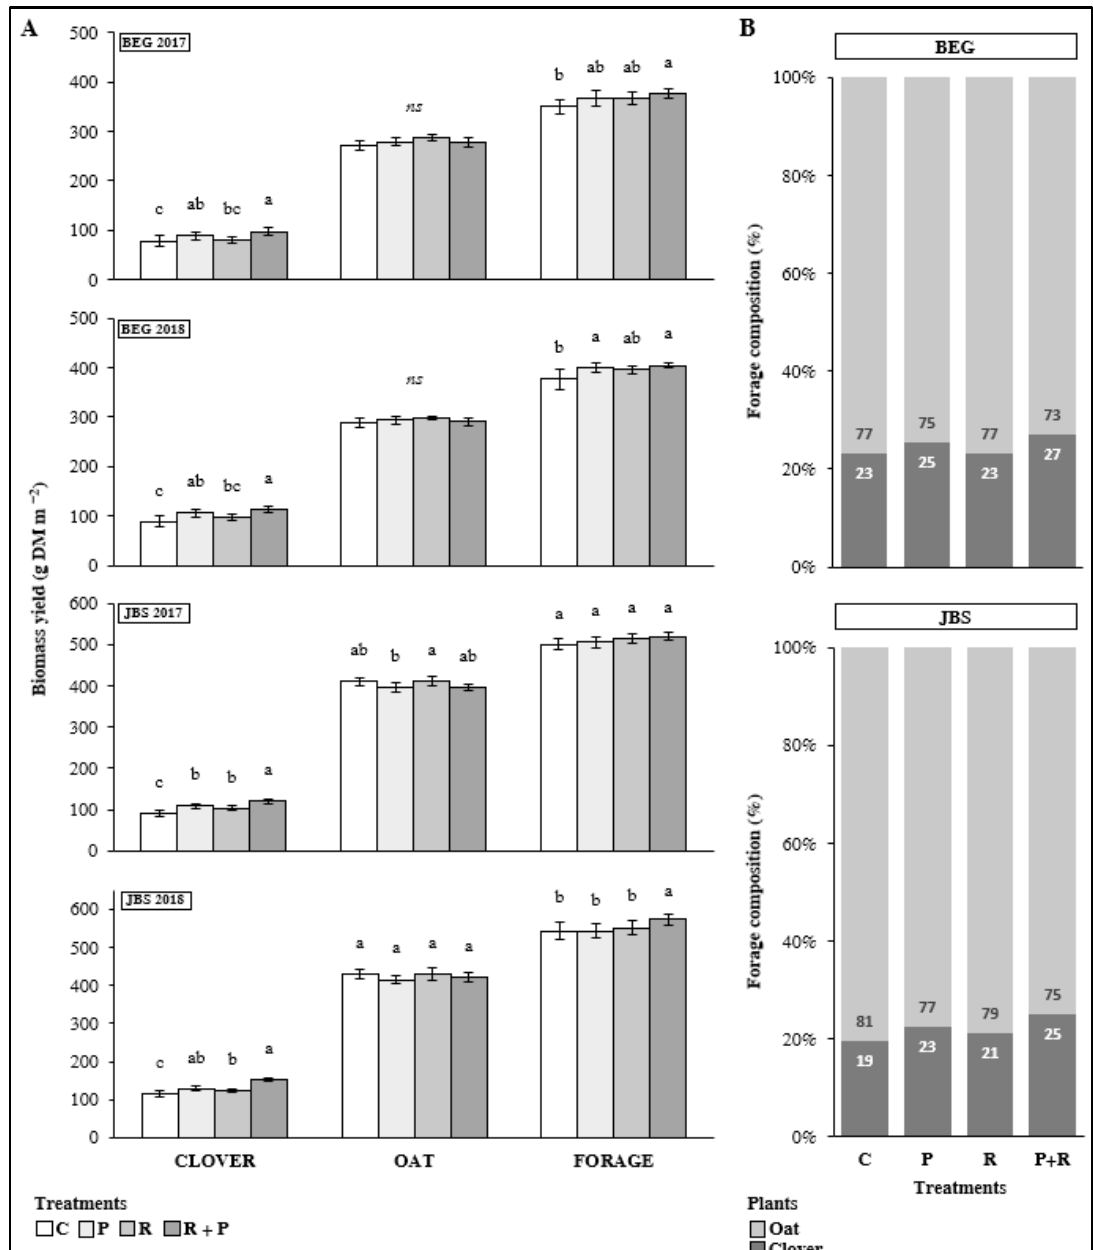
Figure 5. Effects of inoculation and co-inoculation with P. thivervalensis strain T124 and R. legumi- nosarum strain T618 on clover–oat intercrops forage dry weight yield (150 DAS) at BEG and JBS sites for 2017 and 2018 seasons. (Plot ( A ): C, control un-inoculated, P: inoculated with P. thivervalensis strain T124; R: inoculated with R. leguminosarum strain T618; P + R: co-inoculated with T124 and T618 strains; Treatment columns within each clover, oat or forage yield followed by different letters are significantly different ( p < 0.05). The error bar represents the standard error of the mean ( n = 4). Plot ( B ): Clover–oat intercrops forage dry weight fractions presented as percentages averaged for both seasons at each site).